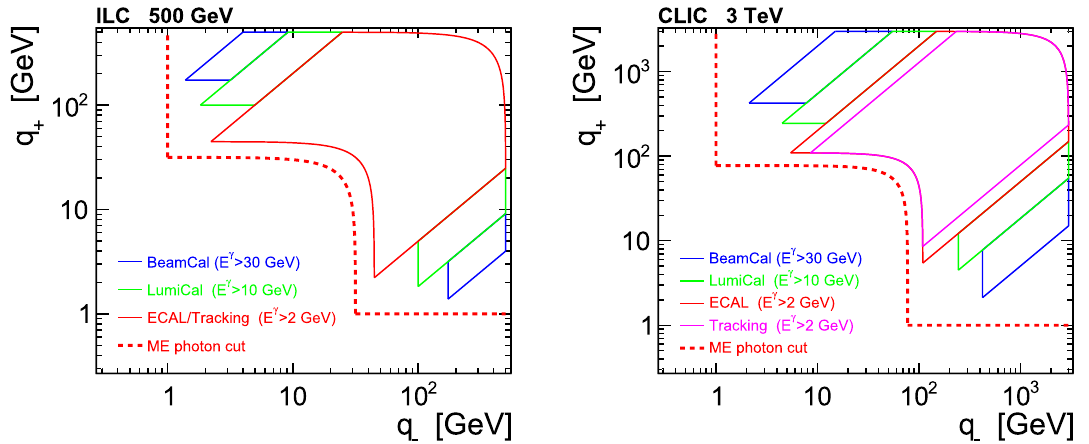
Fig. 3 Detector acceptance in the ( q + , q − ) plane expected for the future experiments at 500GeV ILC (left) and 3TeV CLIC (right). Red dashed lines indicate the cut used to restrict the phase space for ME photon